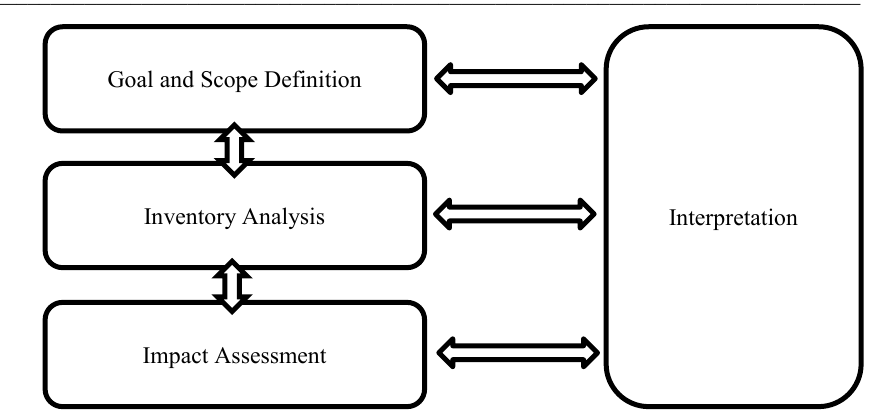
Fig. 1. Life Cycle Assessment (LCA) framework defined by ISO